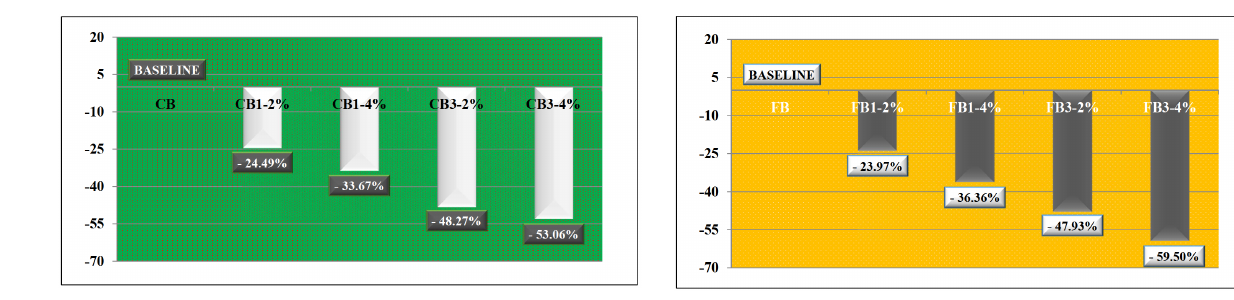
Figure 9: Ballast abrasion in clean-ballast based specimen